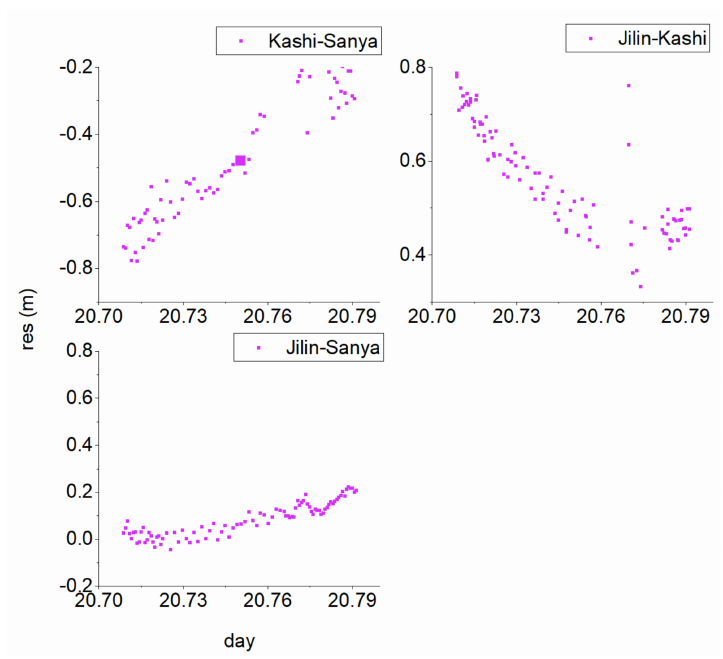
Figure 6. The residuals of three baselines of the VLBI